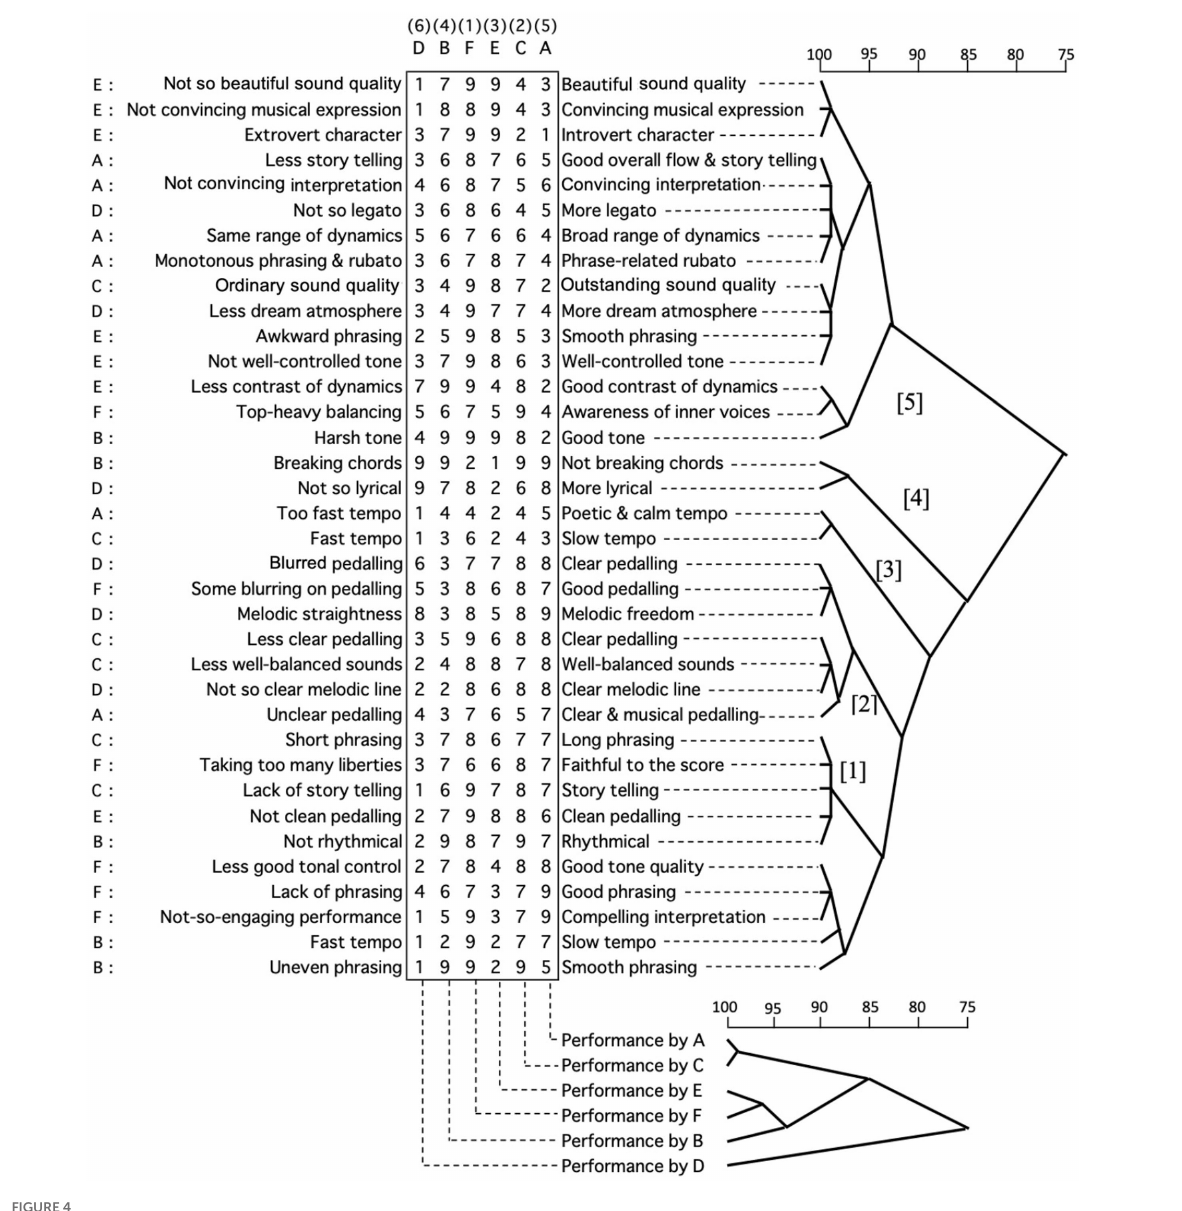
FIGURE 4 Cluster of all performance and constructs from external